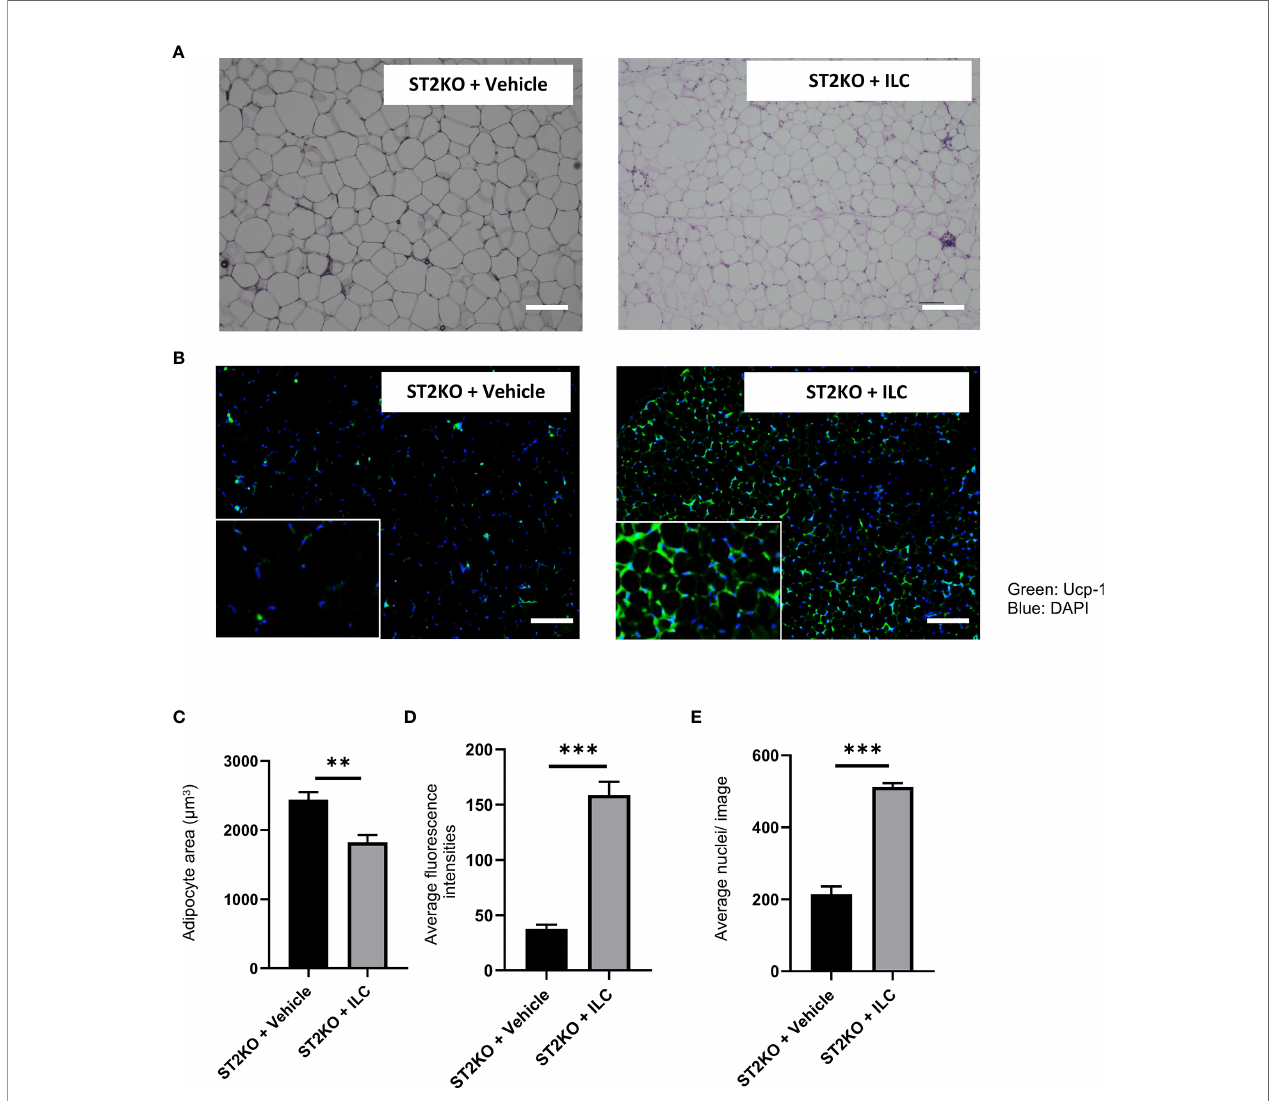
FIGURE 6 | Adoptive transfer of ILCs from WT mice bone marrow increased the expression of Ucp-1 in eWAT. (A) Hematoxylin and eosin-stained eWAT sections, scale bars, 50 m m. (B) The immune histochemistry of eWAT. Green: Ucp-1. Blue: DAPI. Scale bar, 50 µm. (C) Corresponding quantitation presented as the mean adipocyte area (n = 6). (D) The fl uorescence intensity of Ucp-1 (n = 6). (E) The number of cells in an image (n = 6). Data are represented as mean±SD; **p < 0.01, ***p < 0.001 by One-way ANOVA